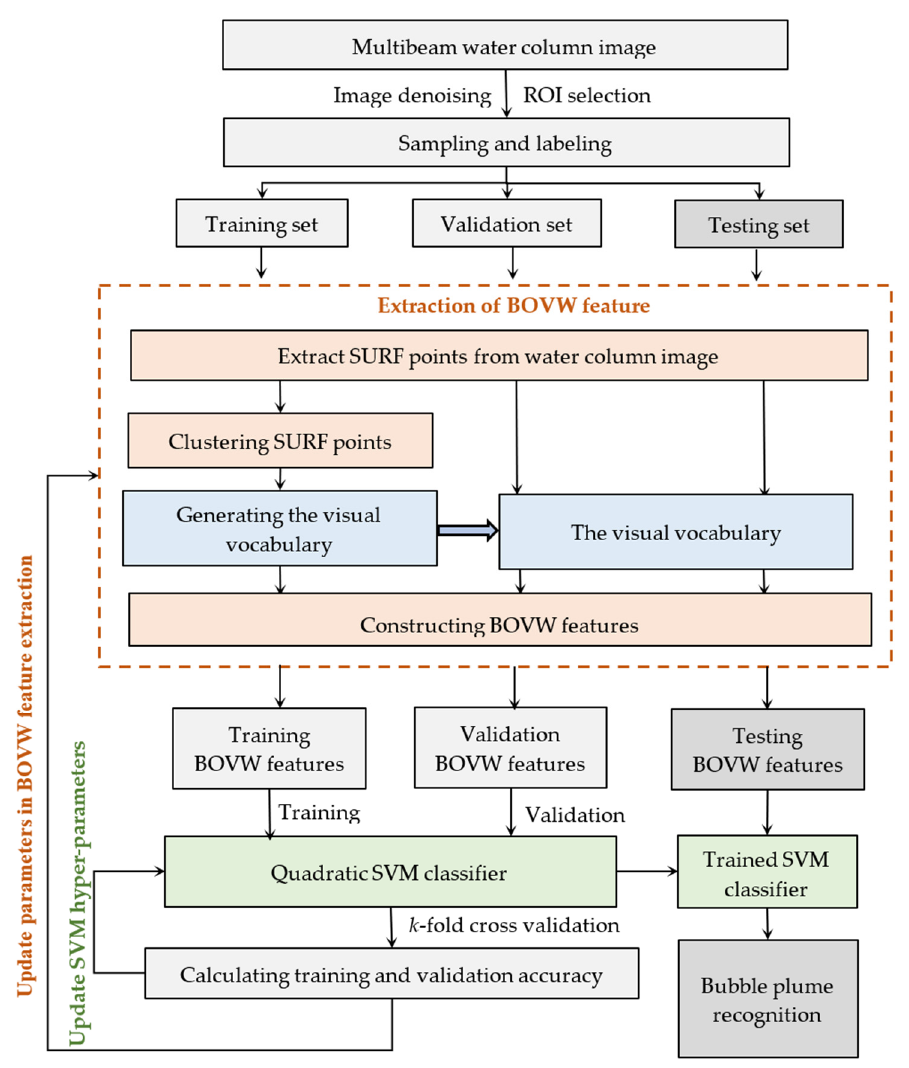
Figure 7. Flow diagram of bubble plume target recognition in water column sampling images based on BOVW features. During the training procedure, the parameters in BOVW feature extraction need to be updated by continually changing the interest point extraction method and the number of the visual vocabulary until the recognition accuracy reaches the maximum value.